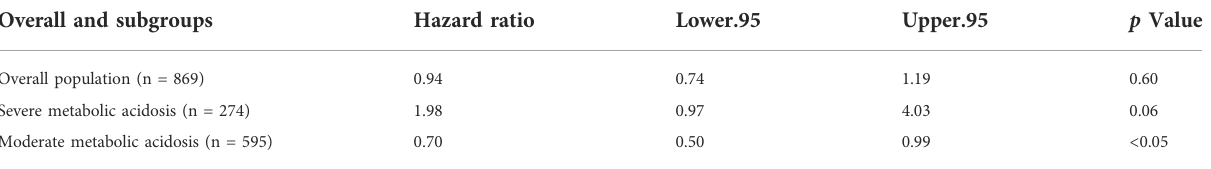
TABLE 3 Association of SB infusion and hospital mortality in the overall and subgroups by using propensity score analysis.